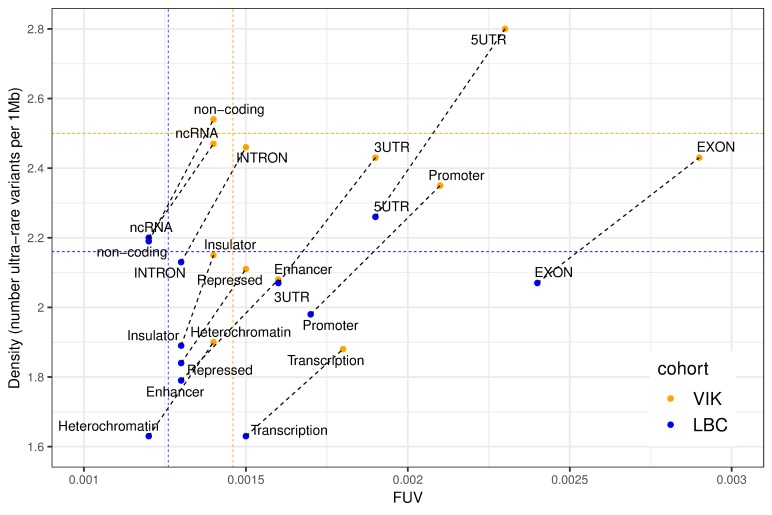
Distribution of ultra-rare SNPs in functional regions.Fraction of ultra-rare variants (FUV) = number of ultra-rare variants / (number of ultra-rare + known variants); Values for regulatory regions are computed as the average over the 9 cell types; non-coding = mappable genome– 5’UTR–exon–intron– 3’UTR–ncRNA; Coloured horizontal and vertical lines represent the genome-wide averages for the two cohorts. Dashed black lines represent the distribution shifts between LBC and VIKING for each of the considered genomic regions. A strictly vertical shift would indicate a proportional increase in the numbers of ultra-rare and known variants from LBC to VIKING, whereas a strictly horizontal shift (no change in the ultra-rare variant density between the two cohorts) would represent a decrease in the number of known variants in VIKING.